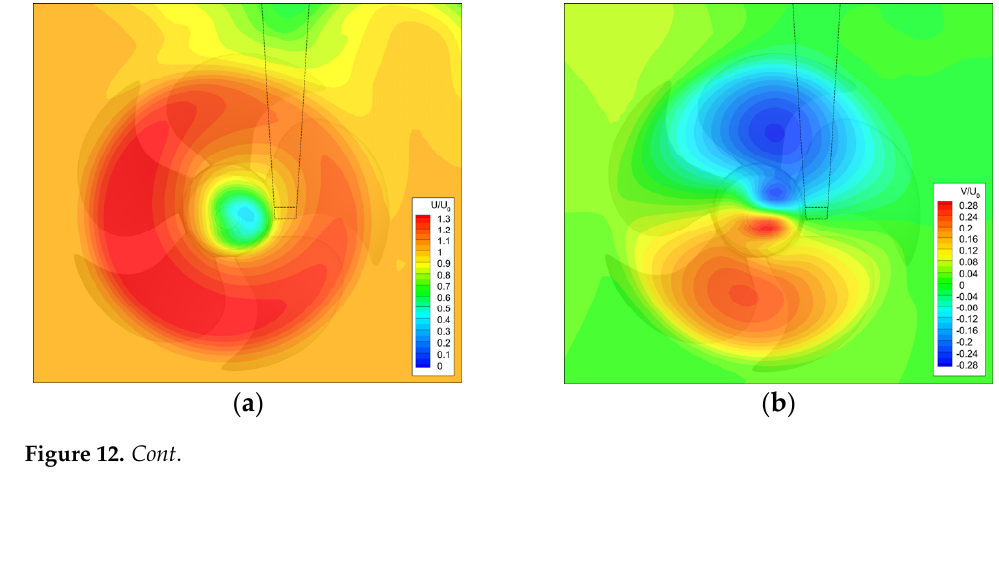
Figure 11. Computational domain and boundary conditions for numerical simulation and mesh strategy for the cavitation tunnel walls and full-appended hull. ( a ) computational domain, ( b ) tunnel prism mesh layer, and ( c ) mesh distribution around the stern.